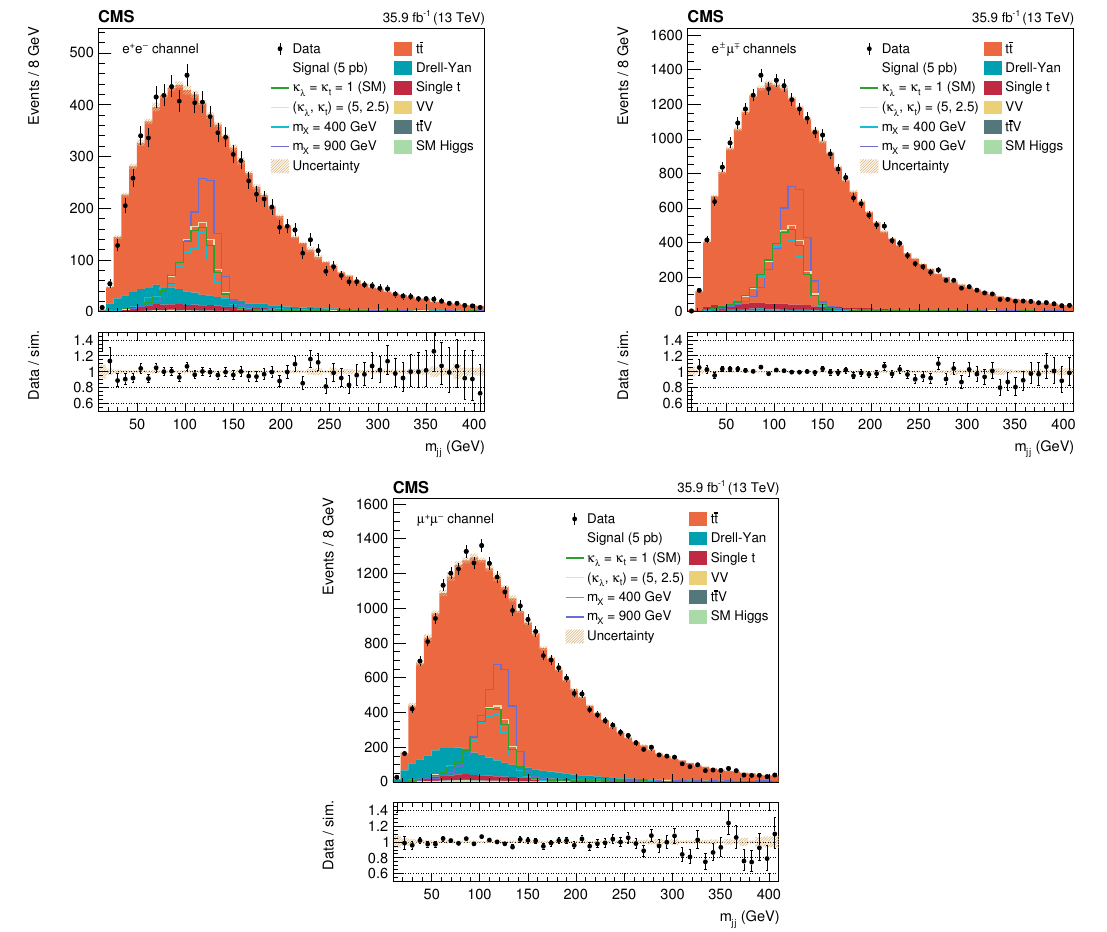
Figure 4 . The m jj distribution in data and simulated events after requiring all selection criteria in the e + e (cid:0) (top left), e (cid:6) (cid:22) (cid:7) (top right), and (cid:22) + (cid:22) (cid:0) (bottom) channels. The various signal hypotheses displayed have been scaled to a cross section of 5 pb for display purposes. Error bars indicate statistical uncertainties, while shaded bands show post-(cid:12)t systematic